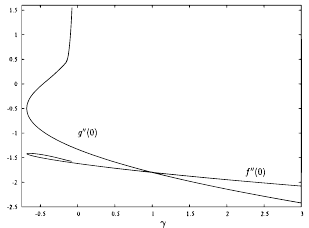
Figure 7. Permeable surface, S (cid:54) = 0: plots of f (cid:48)(cid:48) (0) and g (cid:48)(cid:48) (0) against γ for S = 1 obtained from the numerical solution to equations (2.4)–(2.6),